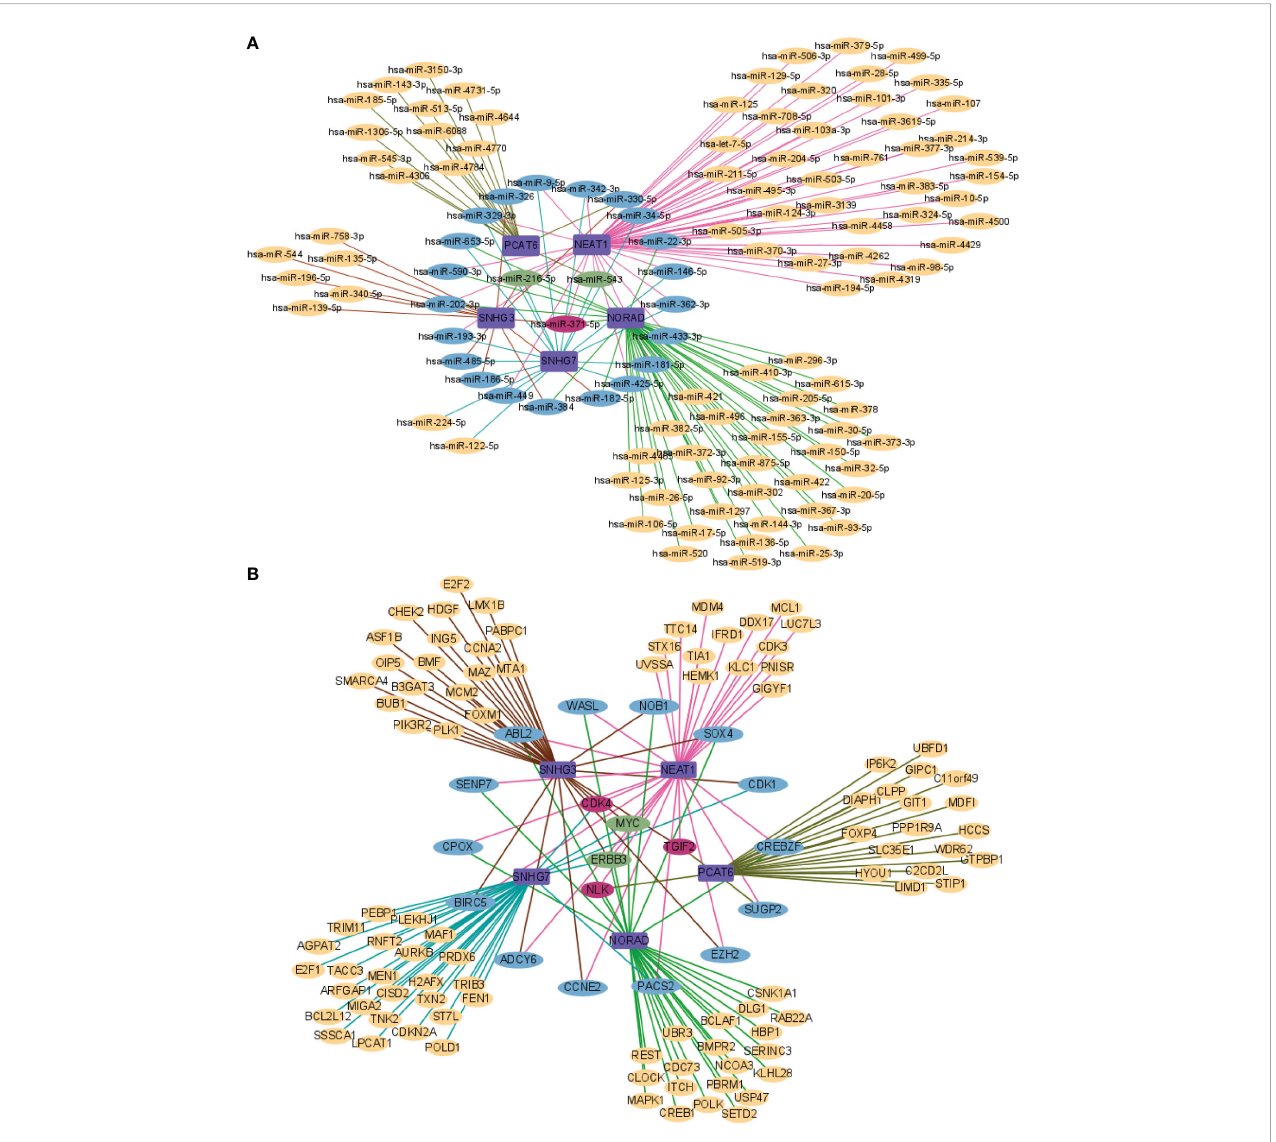
FIGURE 7 Network analysis of lncRNA and targeted genes. (A) lncRNA and miRNA network analysis; (B) lncRNA and mRNA network